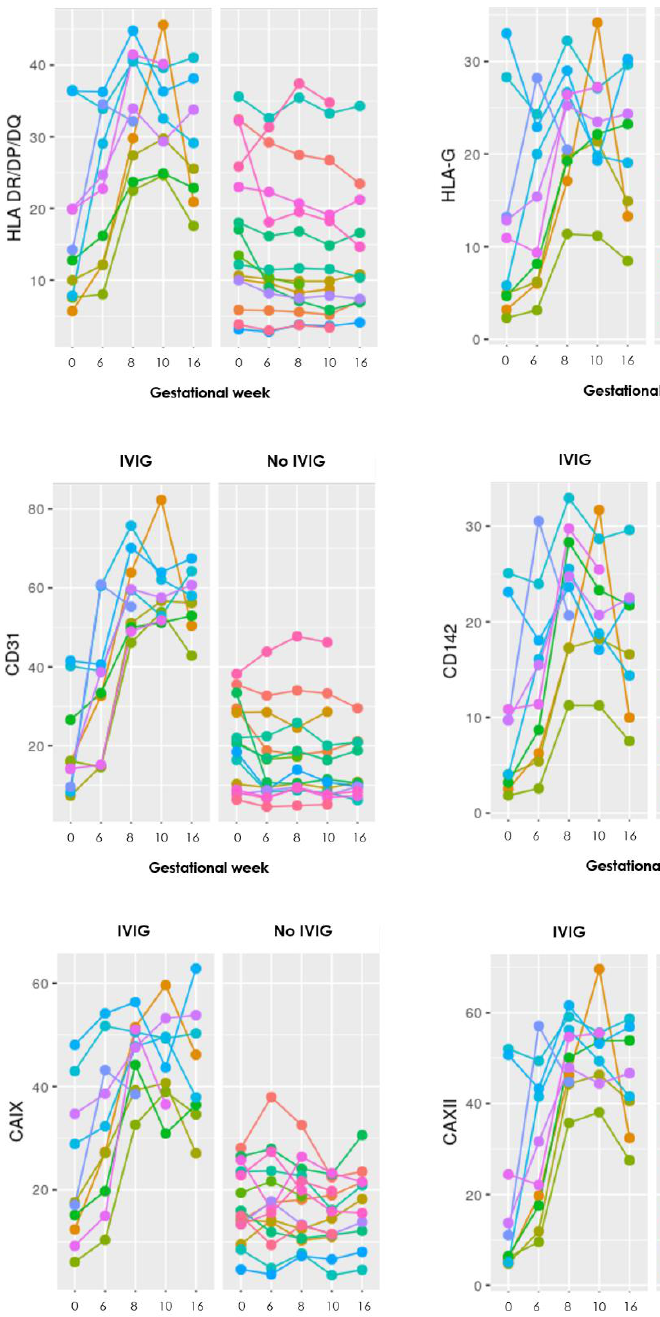
Figure A2. Graphs showing the progression during pregnancy of all 17 EV markers examined with the EV array in the LB group, where each color represents an individual person. To the left are those who received IVIG treatment and to the right those who did not. Gestational week is depicted on the x-axis and absolute levels of the antibody marker along the y-axis.